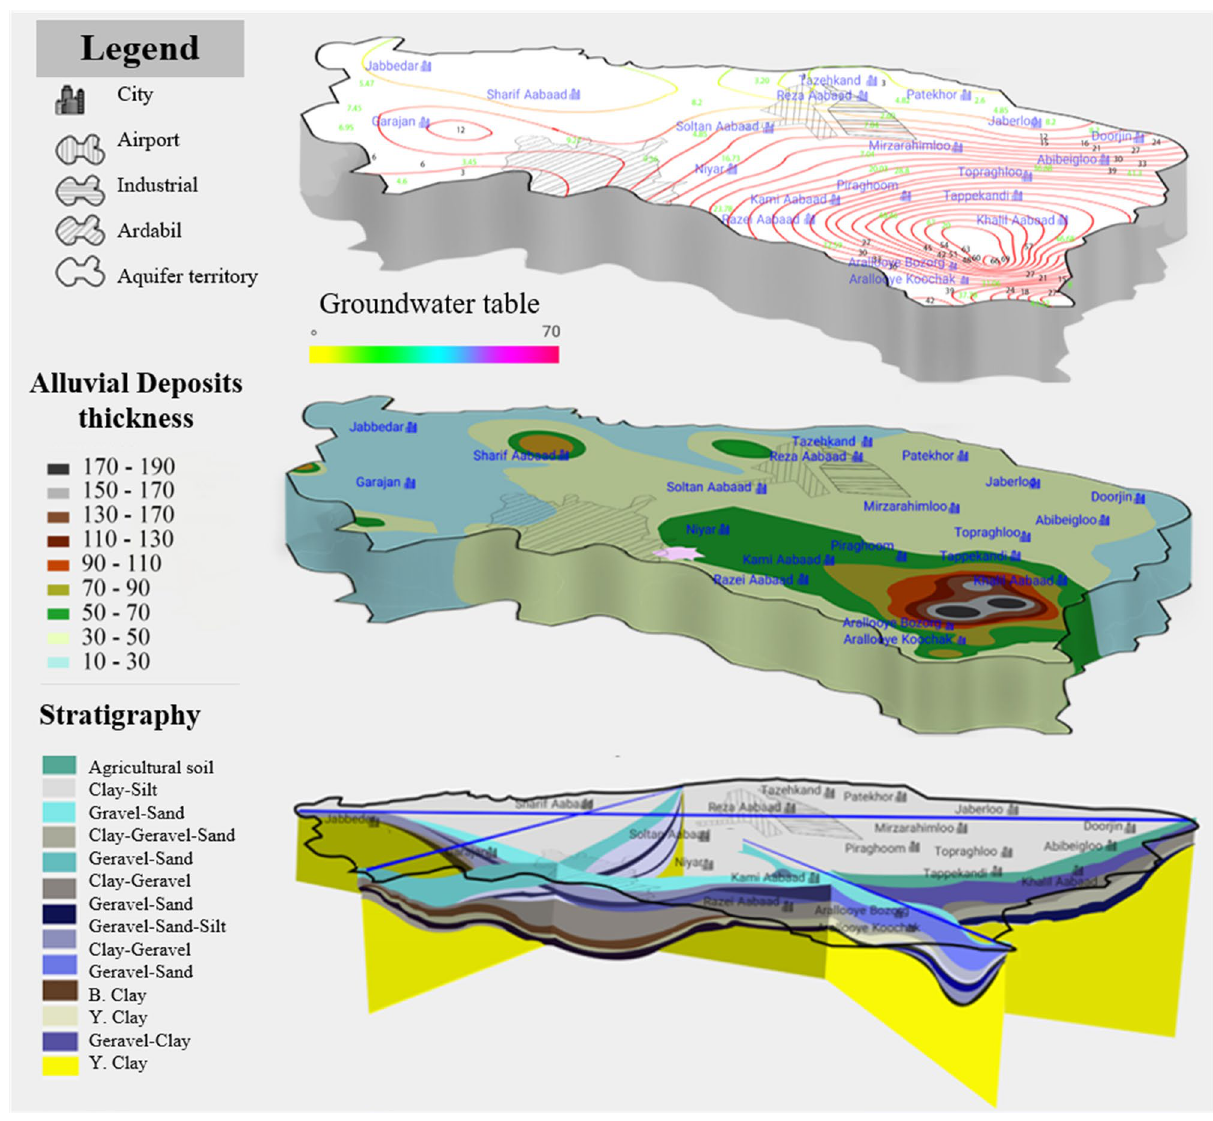
Figure 8. Parameters involved in the issue of subsidence: groundwater table, alluvial deposits thickness, type of soil layers and phase, coherence, phase gradient, and LOS displacement in both radar and geographic coordinates 65 . Figure 9 shows the workflow of time-series analysis by GMTSAR. GMTSAR uses an adaptive power spectrum filter and a Gaussian filter for the unwrapping process (set to default filter parameters of alpha = 0.1 and patch size = 32). In general, the numbers of interferograms associated with a perpendicular baseline of smaller than 120 m and a temporal baseline of smaller than 130 days obtained from S1A images of (A-101) and (D-6) tracks are 101 and 97, respectively. Using the least-squares method, the displacement value of each pixel was estimated in the Arda- bil plain. To make the results comparable with the LiCSBAS/LiCSAR processing chain, the same multilooking factors of LiCSAR data were employed for GMTSAR processing and the coherence threshold was set to 0.06. Figure 10 compares the LiCSBAS velocities with those measured using GMTSAR for the period of March 2017 to January 2019 for A-101 track. Figure 10a shows the maximum subsidence rates measured using the GMTSAR and Fig. 10b shows the results obtained using LiCSBAS. As observed in this figure, in terms of the maximum subsidence rates, both packages show close values of −53 mm/yr (GMTSAR) and −52 mm/yr (LiCSBAS). For the D-6 track, these values changed to −46 mm/yr (using GMTSAR) and −49 mm/yr (using LiCSBAS), as observed in Fig. 10c and d. Both GMTSAR and LiCSBAS results showed a major land subsidence concentrated in the southeast of the Ardabil plain, near the city of Araloyebozorg and Khalilabad. However, the difference between LiCSBAS and GMTSAR results is the number of masked pixels in areas of low coherence which is significantly larger in GMTSAR. In Fig. 11, the average coherence maps (March 2017 to January 2019) in Ardabil plain using GMTSAR and COMET-LiCSAR system are presented. Based on the results presented in Fig. 11a and b, the values of aver- age coherence for GMTSAR and COMET-LiCSAR are 0.27 and 0.37, respectively. Both results showed high